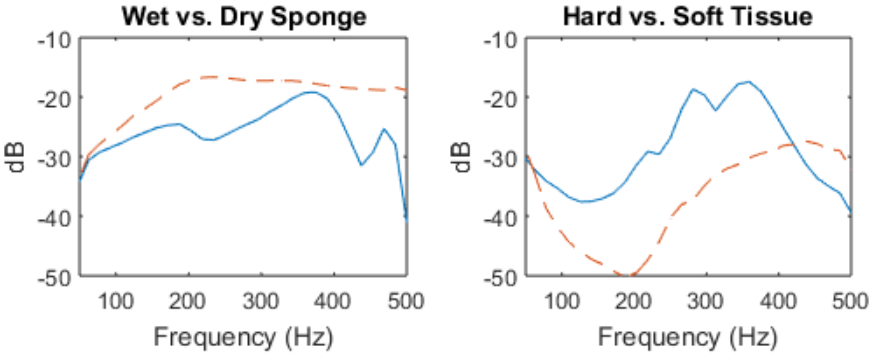
Figure 4. The frequency spectrum from 0–500 Hz for sound signals recorded for the wet (dotted line) vs. dry (solid line) sponge, and for the stomach (soft tissue, solid line) vs. knee (hard tissue, dotted line). Lines represent mean values from 10 consecutive measurements. The sponge experiment findings are consistent with physical predictions that accumulation of water, which reduces acoustic mismatch, leads to improved transmission of higher frequencies. The response for the knee is similar to the wet sponge and appears to behave as a high-pass filter; however, the effect is less pronounced and begins to attenuate above 450 Hz. Figure from